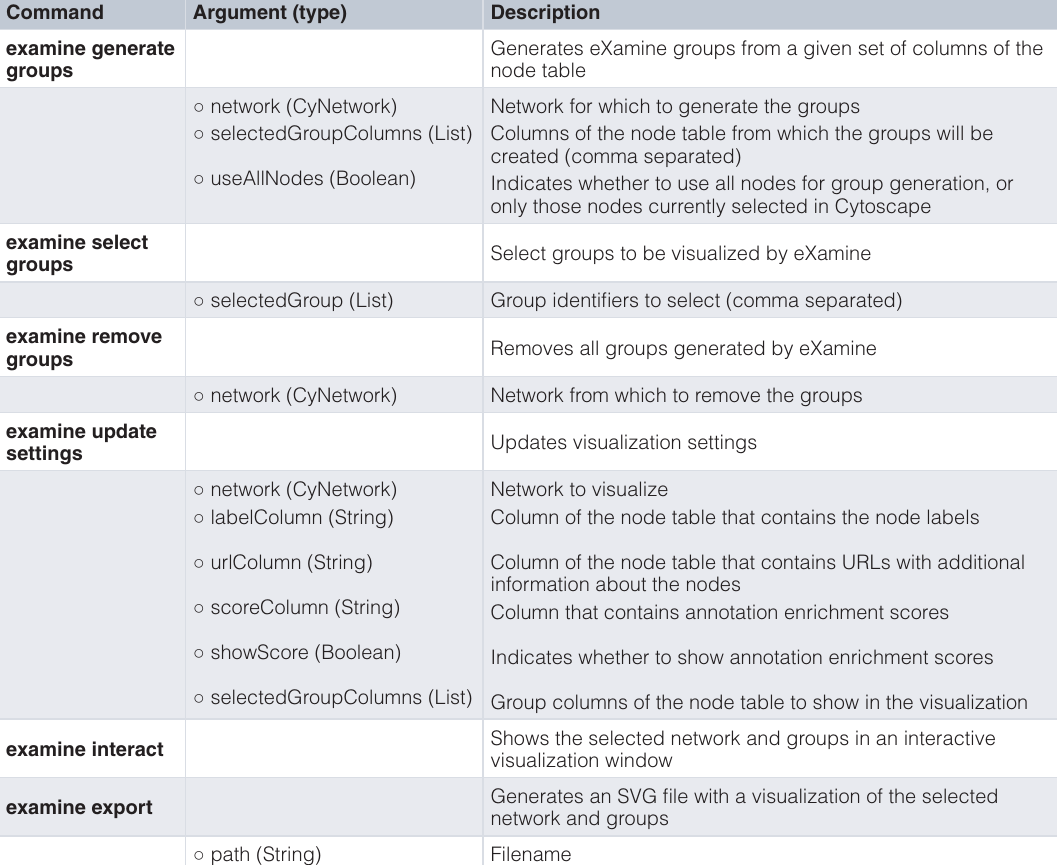
Table 1. Application Programming Interface (API) of Cytoscape commands provided by eXamine. Figure 1 shows an example workflow using the below